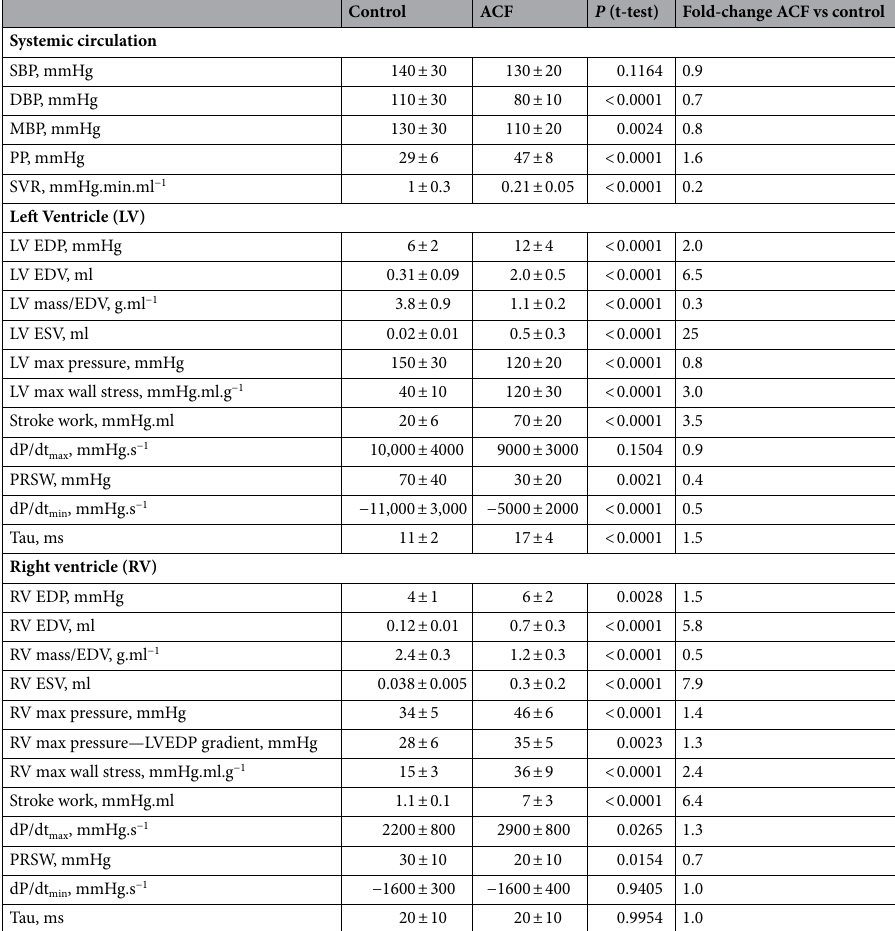
Table 2. Hemodynamic data from pressure–volume analysis. Values are expressed as mean ± SD. SBP, systolic blood pressure; DBP, diastolic blood pressure; MBP, mean blood pressure; PP, pulse pressure; SCR, systemic vascular resistance; LV, left ventricle; RV, right ventricle; PRSW, preload-recruitable stroke work; EDP, enddiastolic pressure; EDV, enddiastolic volume; ESV, endsystolic volume. For other abbreviations, see